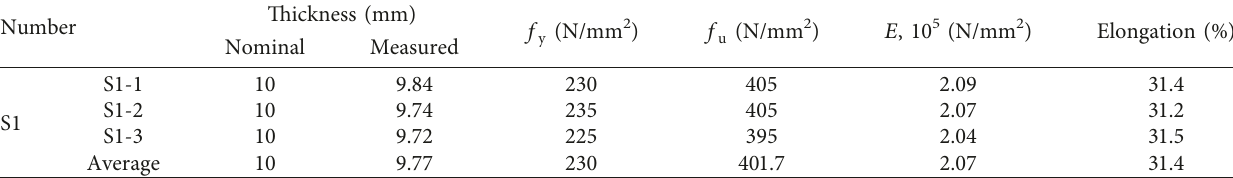
Table 3: Result of tensile coupon test.